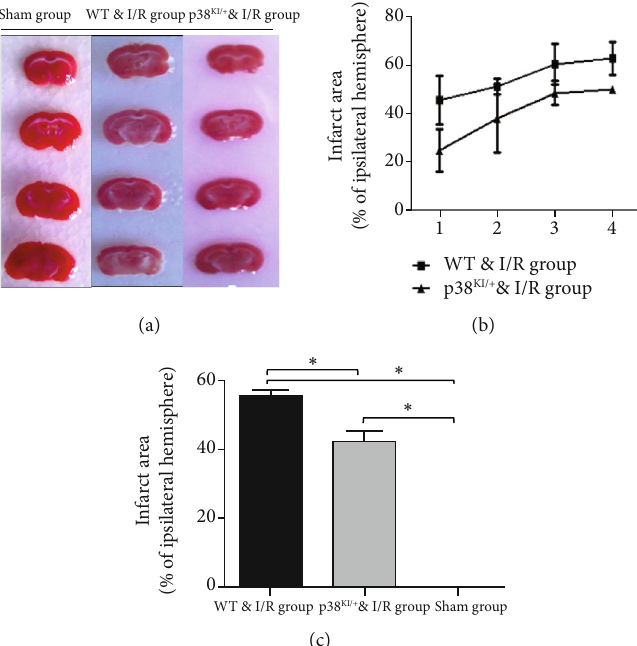
Figure 7: p38 MAPK knockdown rescues brain injury after cerebral ischemia and reperfusion. (a) TTC staining sections graph at 1d cerebral ischemia-reperfusion in the sham group, the p38 KI/+ & I/R group, and the WT & I/R group. The white color of sections means the infarct area. (b) The bar graph indicates quantitative infarct area with the TTC staining at 1 d in the sham group, the p38 KI/+ & I/R group, and the WT & I/R group. (c) Quantitative infarct volume with the TTC staining at 1d cerebral ischemia-reperfusion in the sham group, the p38 KI/+ & I/R group, and the WT & I/R group; n = 3 per group; ∗ p < 0 : 05 , sham group vs. I/R group; ∗ p < 0 : 05 , p38 KI/+ & I/R group vs. I/R group. ∗ p < 0 : 05 by one-way